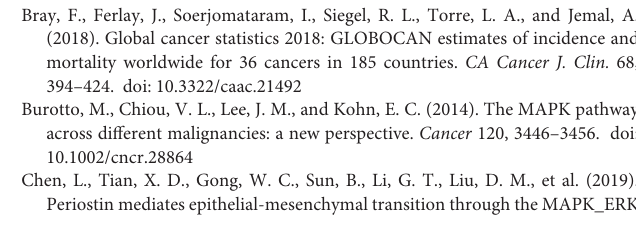
Supplementary Figure 2 | (A–J) The association between 10 out 11 prognostic lncRNAs and patients’ prognosis by KM analysis (log-rank test) (all P < 0.05). (K) LncRNA analysis of cp-score of patients with T1/2 and T3/4 ( P = 0.18). Supplementary Figure 3 | (A–E) The dendrogram of different HC methods for ESCC patients from TCGA, among which the ward showed the best clustering. (F) The silhouette plot showed the optimal number of clusters ( k = 2). (G,H) Silhouette analysis of the ward method (G) was slightly inferior to the k -means (H) . (I) Venn diagram showed the intersections of the three lncRNAs from diagnosis, prognosis, and subtyping sections. (J,K) OS for each of the lncRNA pattern in each subtype in both the training cohort (TCGA) and validation cohort (GEO) (log-rank test, P > 0.05). Supplementary Figure 4 | (A,B) Level of AC007128.1 in the nuclear and cytoplasmic fractions of KYSE150 and EC109 cells. (C,D,H,I) Growth curves of ESCC cells. Numbers of cells were determined at 24 h intervals after transfection with siAC007128.1-2 or pcDNA-AC007128.1 using the CCK-8 assay. (E)